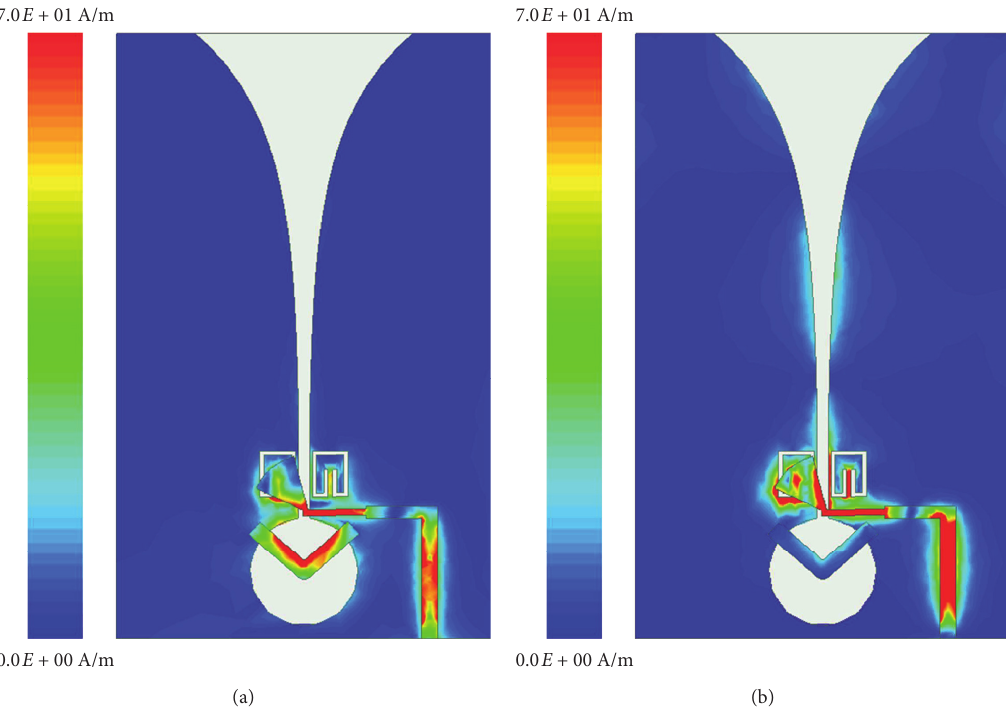
Figure 6: Simulated surface current distribution on the radiating patch of the proposed antenna at the corresponding central frequency of the notched band at (a) 5GHz and (b) 5.9 GHz.